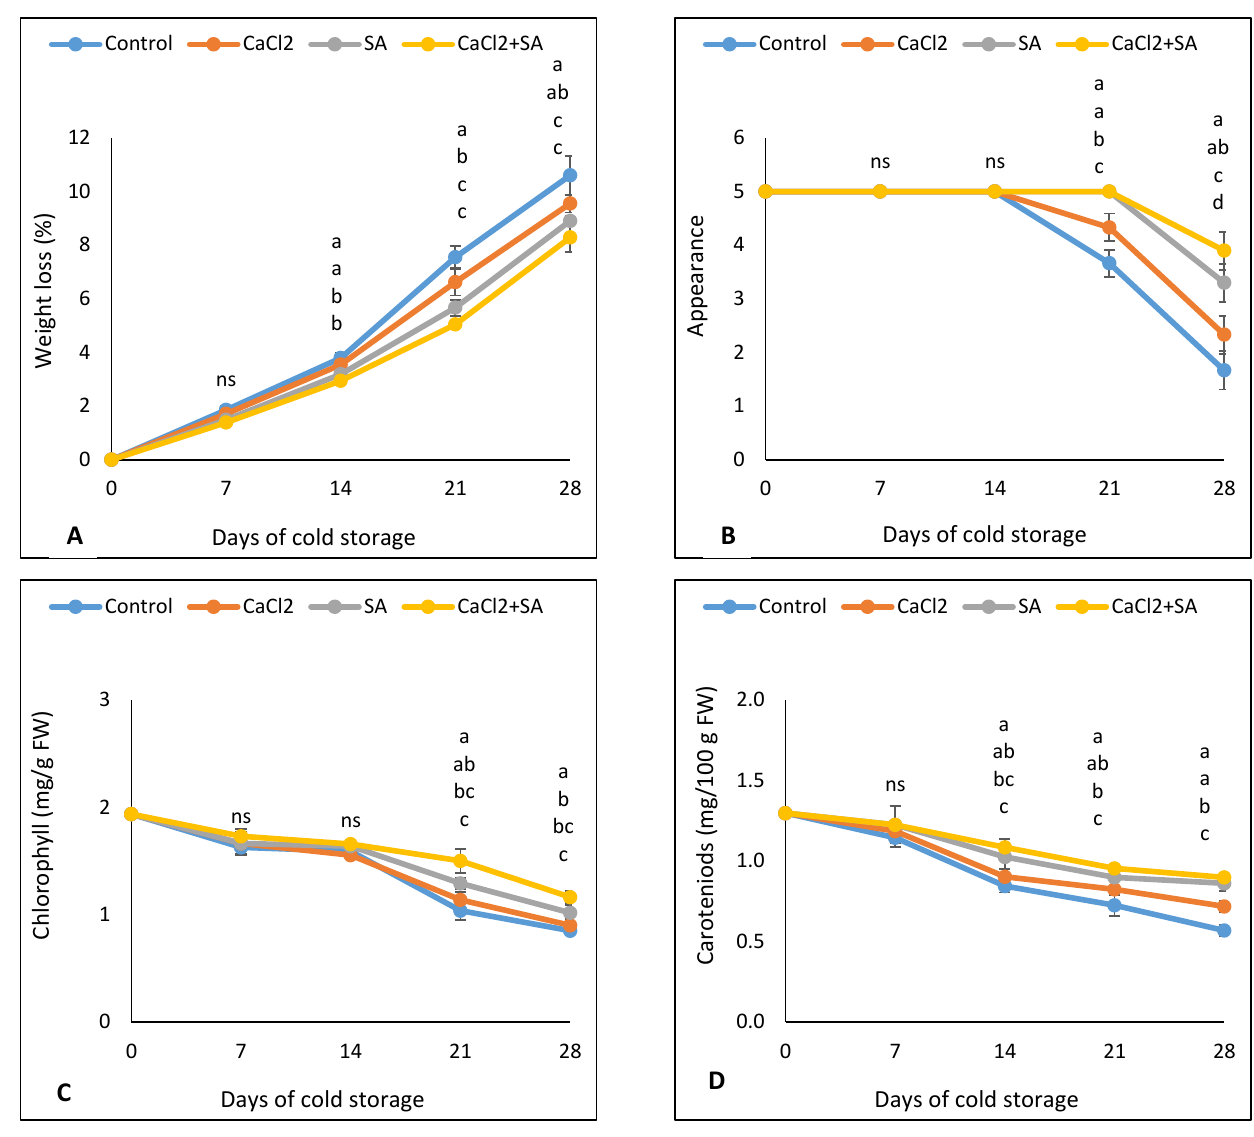
Figure 2. Effect of SA and CaCl 2 and their combination on ( A ) weight loss, ( B ) appearance, ( C ) chlorophyll content, and ( D ) carotenoids of broccoli florets stored at 5 ◦ C for 28 days. Val- ues are means ± SE from three replicates ( n = 3). Same letter means no significant differences between the values ( p < 0.05) according to Duncan